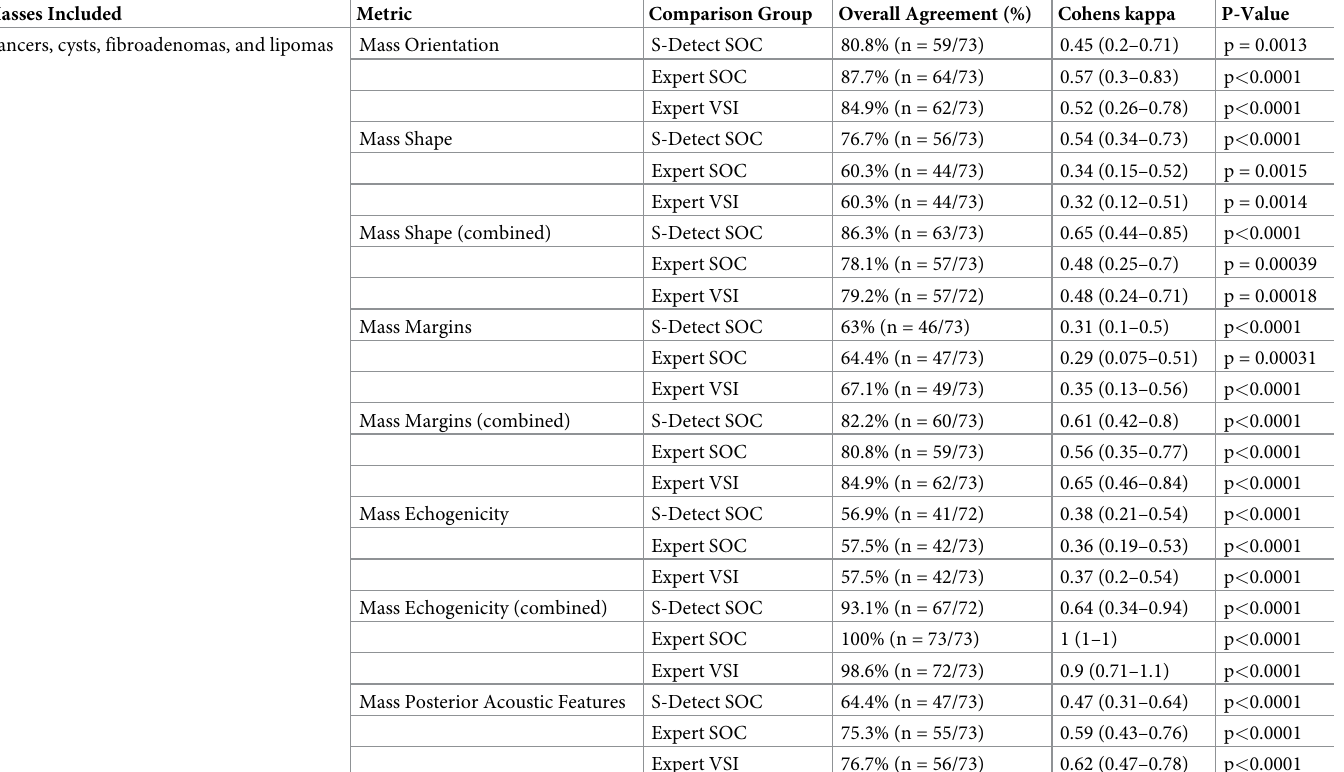
Table 4. Agreement on mass characteristics between S-Detect interpretation of VSI, compared to other interpretations, sub-divided by the masses included in the analysis. The combined mass shape analysis is between “round/oval” or “irregular.” The combined margin analysis is between “circumscribed” or “non-circumscribed.” The combined echogenicity analysis is between “anechoic/hypoechoic/complex cystic or solid,” “isoechoic/hyperechoic,” or “heterogenous.” SOC = standard of care. Masses